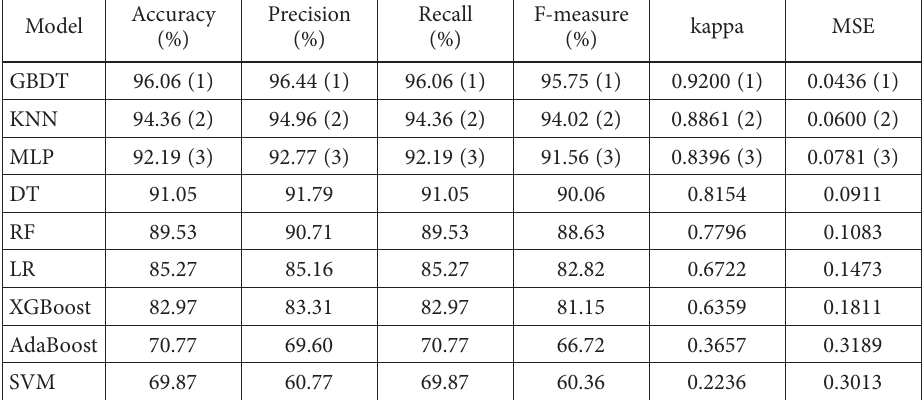
Table 5. Results of ML